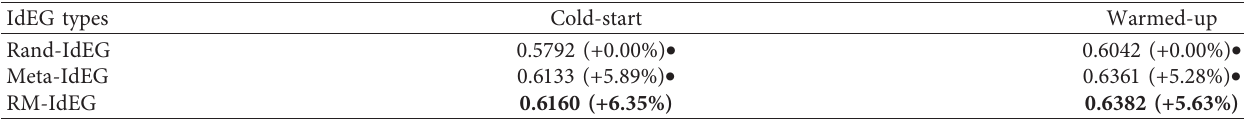
Table 6: Testing AUC comparison of different IdEGs on the Taobao-Fresh dataset. The best ones are shown in